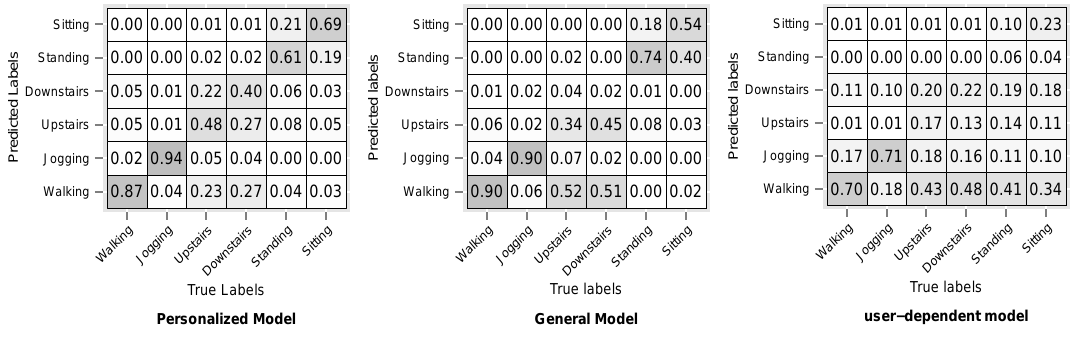
Figure 8. D3: WISDM sensor dataset Confusion Matrix.